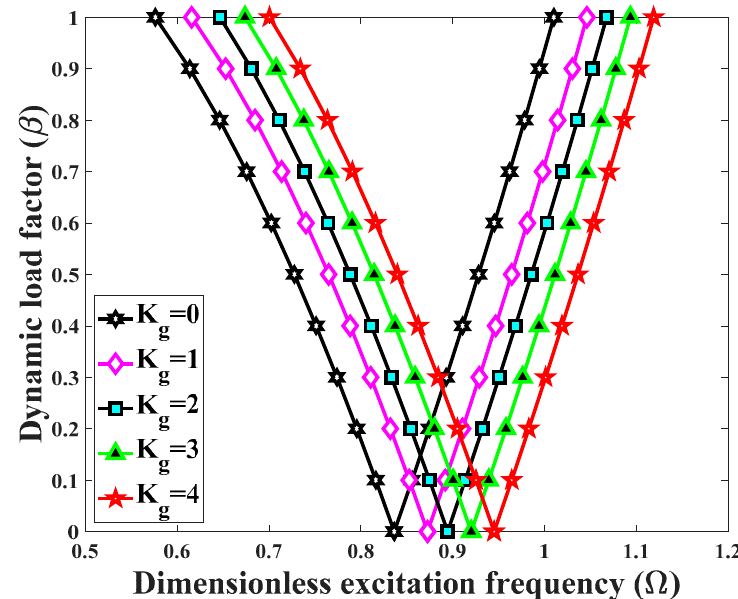
h / R = 0.02, L / R = 1, α = 0.3, K g = 0, n x = n z = 1.5.